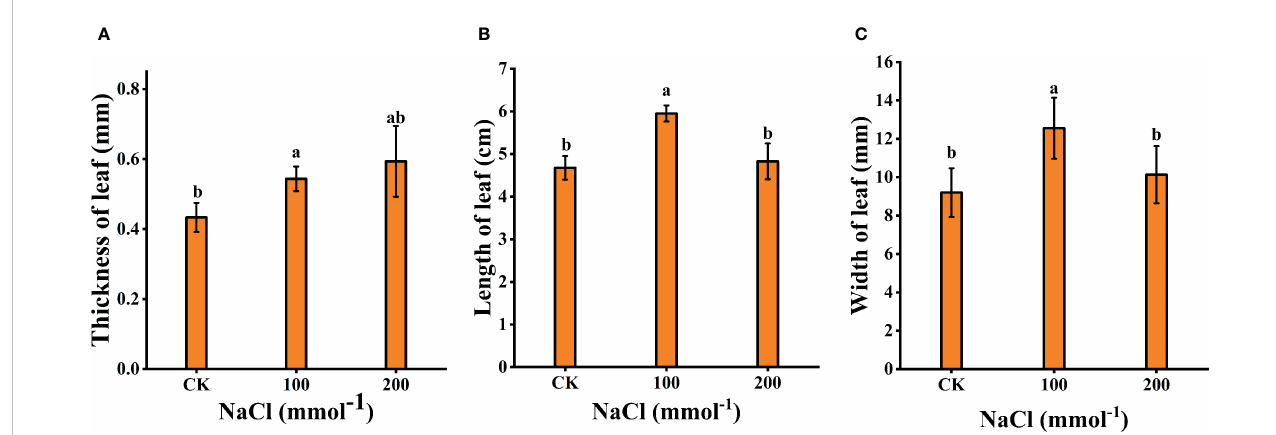
FIGURE 2 Effects of different salt concentrations on the growth of young seedlings in Lycium barbarum L. (A) Thickness of leaf. (B) Length of leaf. (C) Width of leaf. Data were analyzed by a Student ’ s t-test; a p <0.05 was considered as statistically signi fi